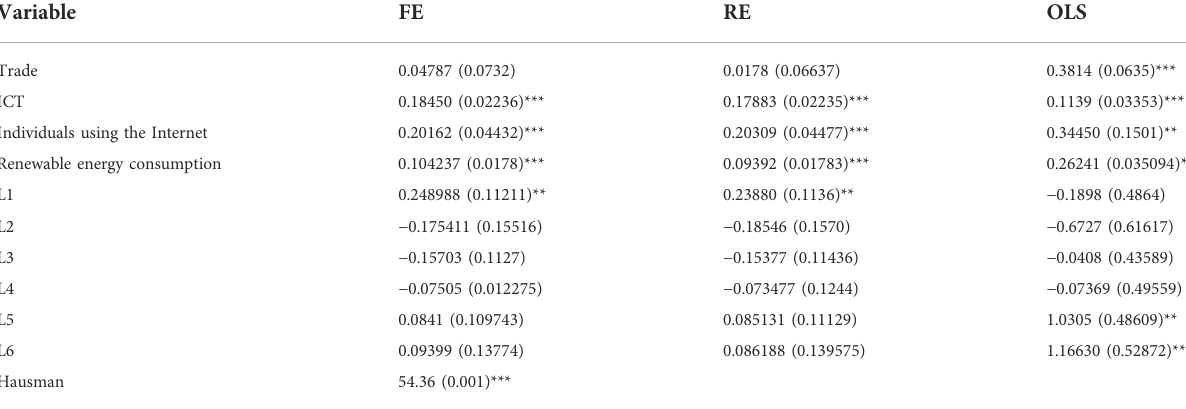
TABLE 3 Static model: the results of OLS, FE, and RE effects.